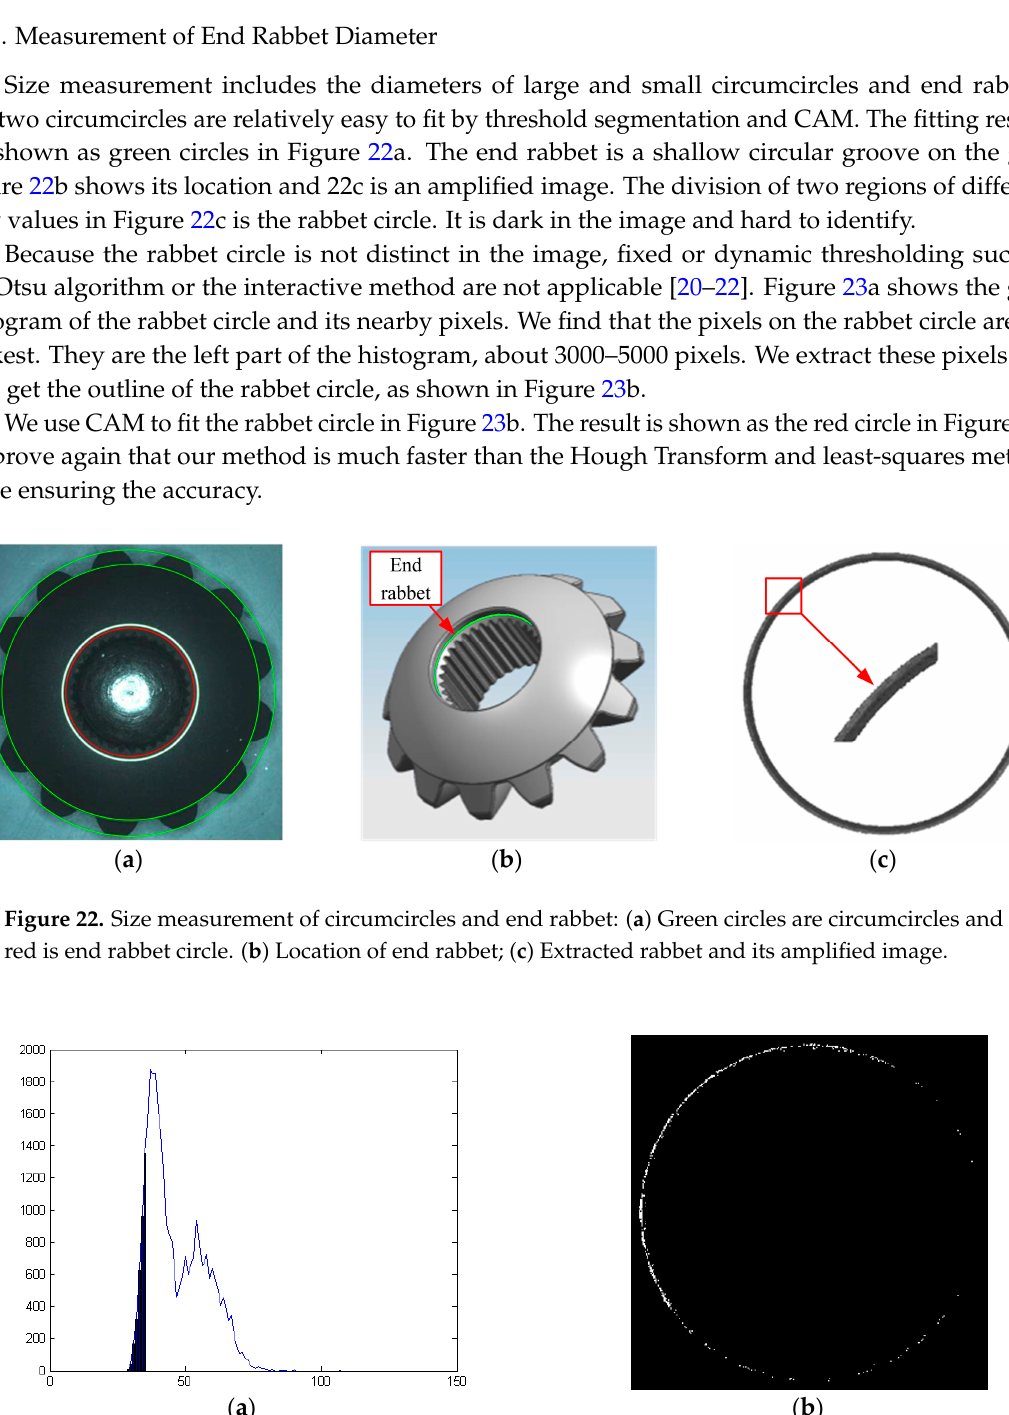
Figure 23. ( a ) Histogram of End rabbet and nearby pixels; ( b ) Extract the outline of rabbet circle.